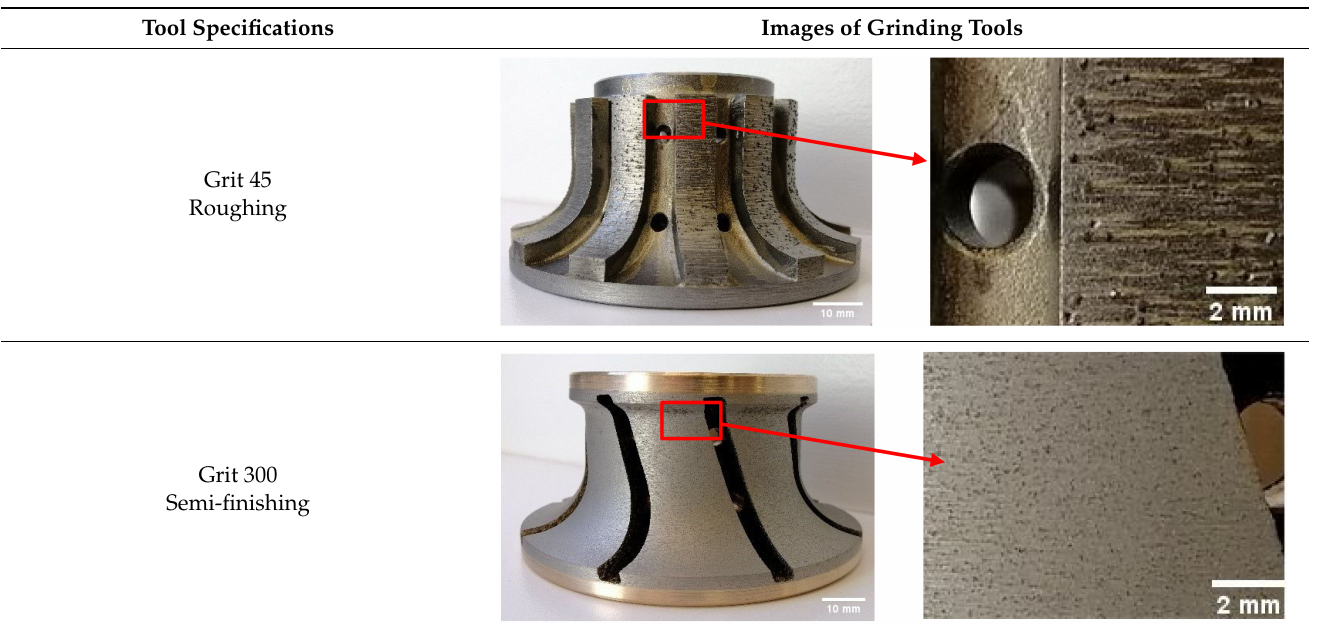
Table 1 gives examples of the tools used in each stage and the details. Table 1. Details of used edge